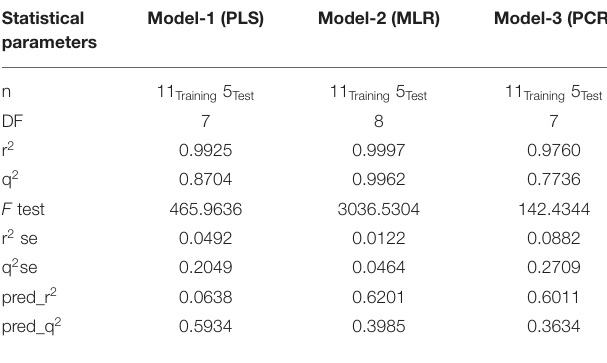
Table 2C | Statistical results of 2D-QSAR models against S. rolfsii .